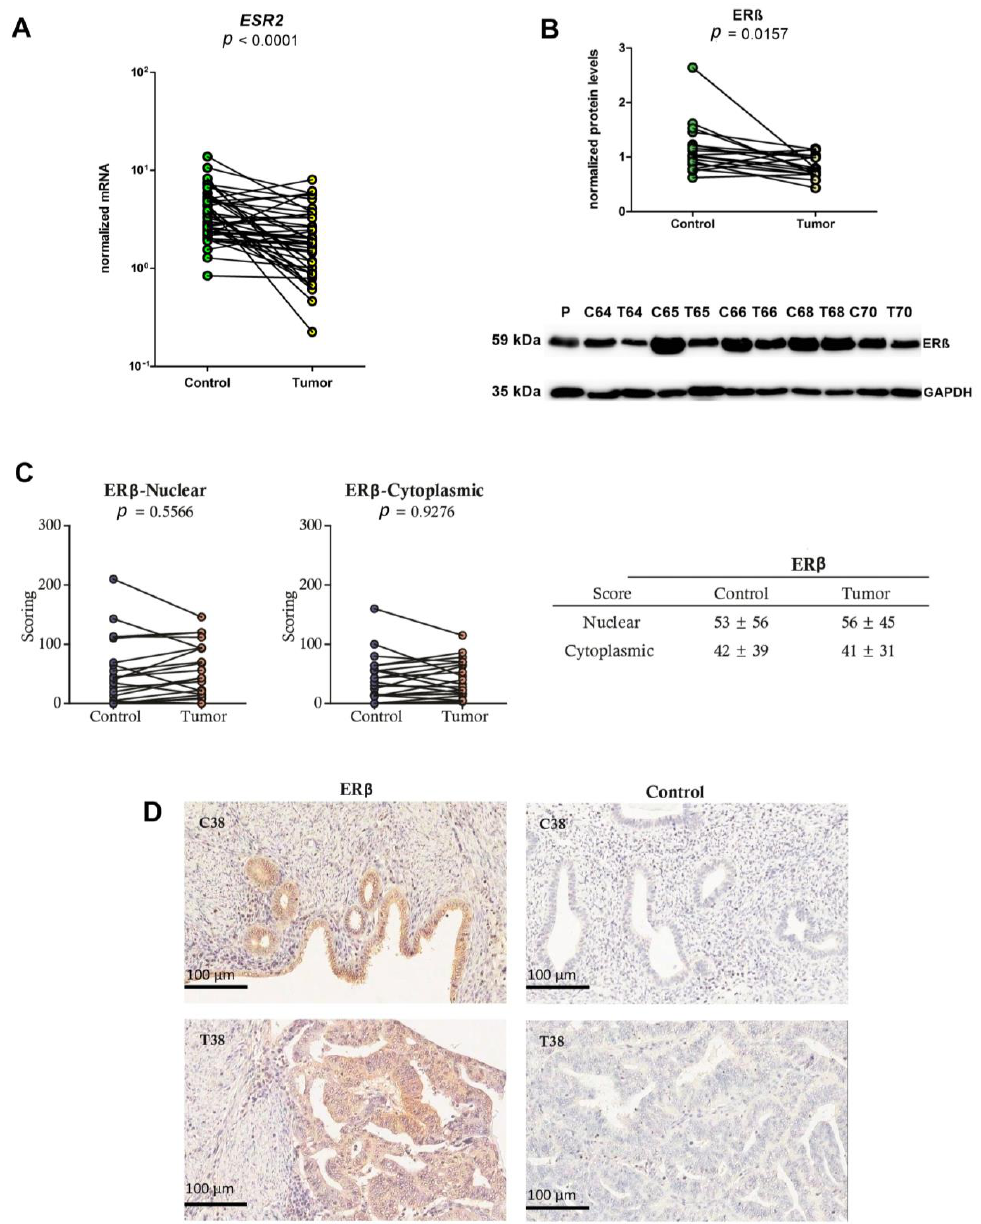
Figure 3. ERβ mRNA and protein levels in endometrial cancer and adjacent control endometrium. ( A ) Before-and-after graph shows the normalized expression levels of the ESR2 gene in control endometrial tissue (Control) and the corresponding EC tissue (Tumor). The levels of gene expression are on a logarithmic scale. ( B ) ECL detection of ER β (59 kDa band). 18 paired samples were analyzed using anti-ER β antibodies (ab3576, Abcam, Cat. #: ab3576, Lot: GR208064-1) and GAPDH was used as a normalization control. Before-and-after plots show quantification of Western blotting data. Below, representative membrane with ER β and GAPDH staining is shown. EC tissue (T), adjacent control endometrial tissue ( C ), placenta (P) was used as a control tissue. ( C ) IHC scores in 21 samples from adjacent control endometrial tissue (Control) and EC tissue (Tumor). Tables show mean scores ± standard deviations, while before-and-after graphs show nuclear and cytoplasmic ER β (anti-ER β antibodies, 14C8, GeneTex, Cat. #: GTX70174, Lot: 20882 (1:100). ( D ) IHC staining in representative paired adjacent control endometrial tissue (C38) and EC tissue (T38) for ER β . In the negative controls (Control), the primary antibodies were replaced with serum of the same animal species (rabbit, mouse). Anti-ER β antibodies were validated (Supplementary Figure S6 and Table